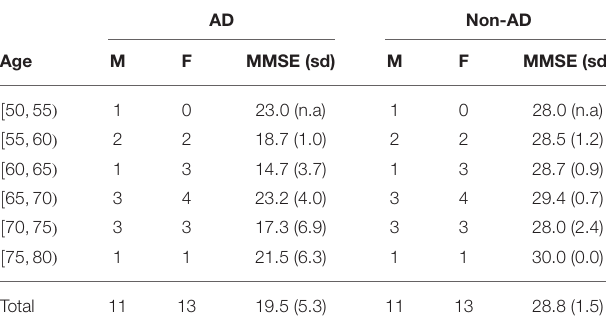
TABLE 3 | ADReSS test set from Luz et al. (2020): basic characteristics of the patients in each group (M, male; F, female).